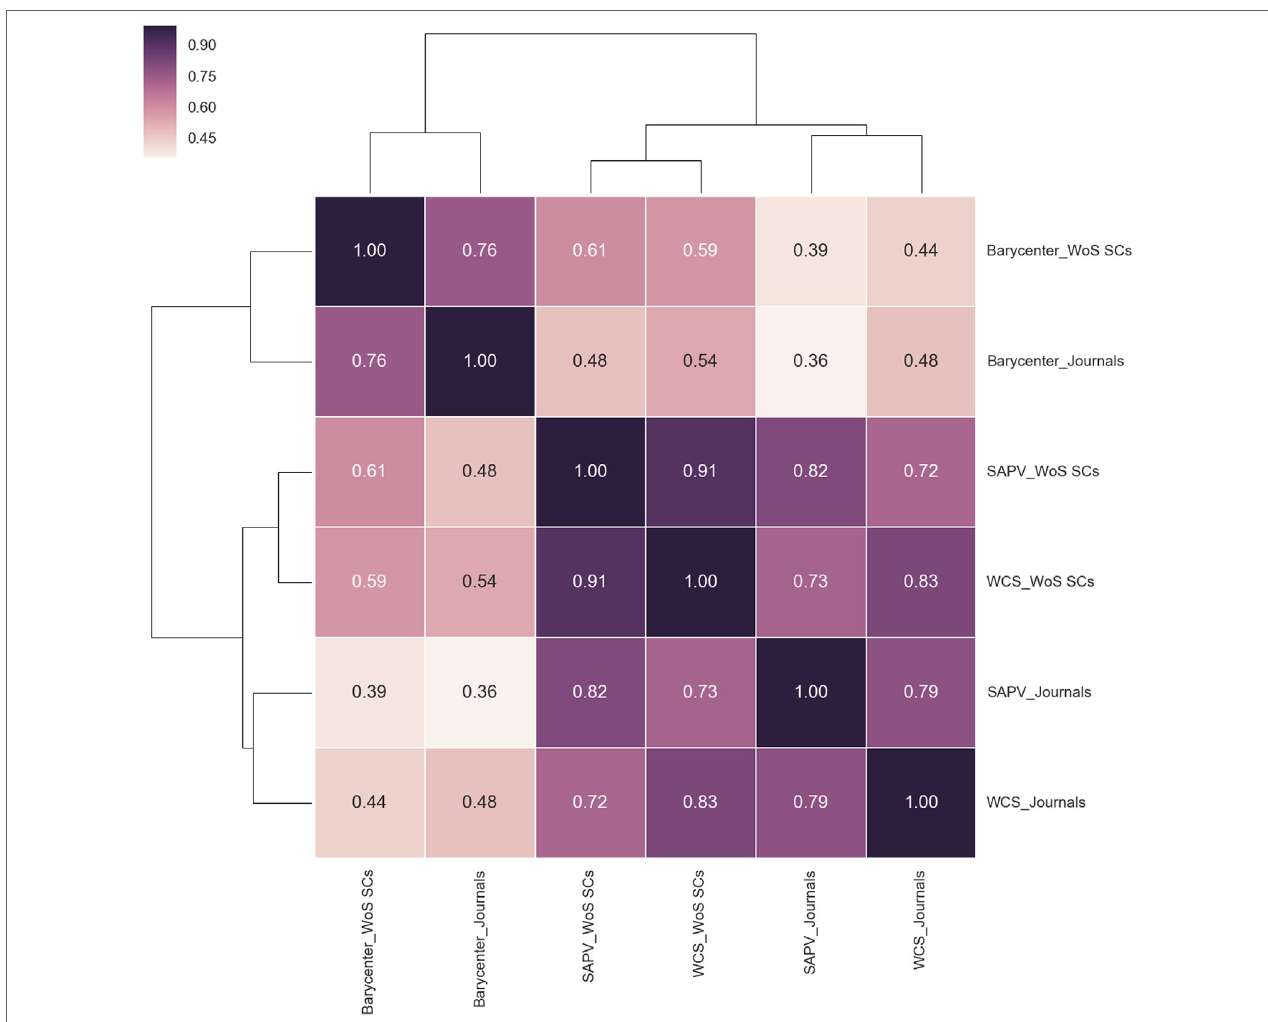
FigUre 3 | Heat map with hierarchical clustering based on correlation coefficient between six approaches in the six departments.